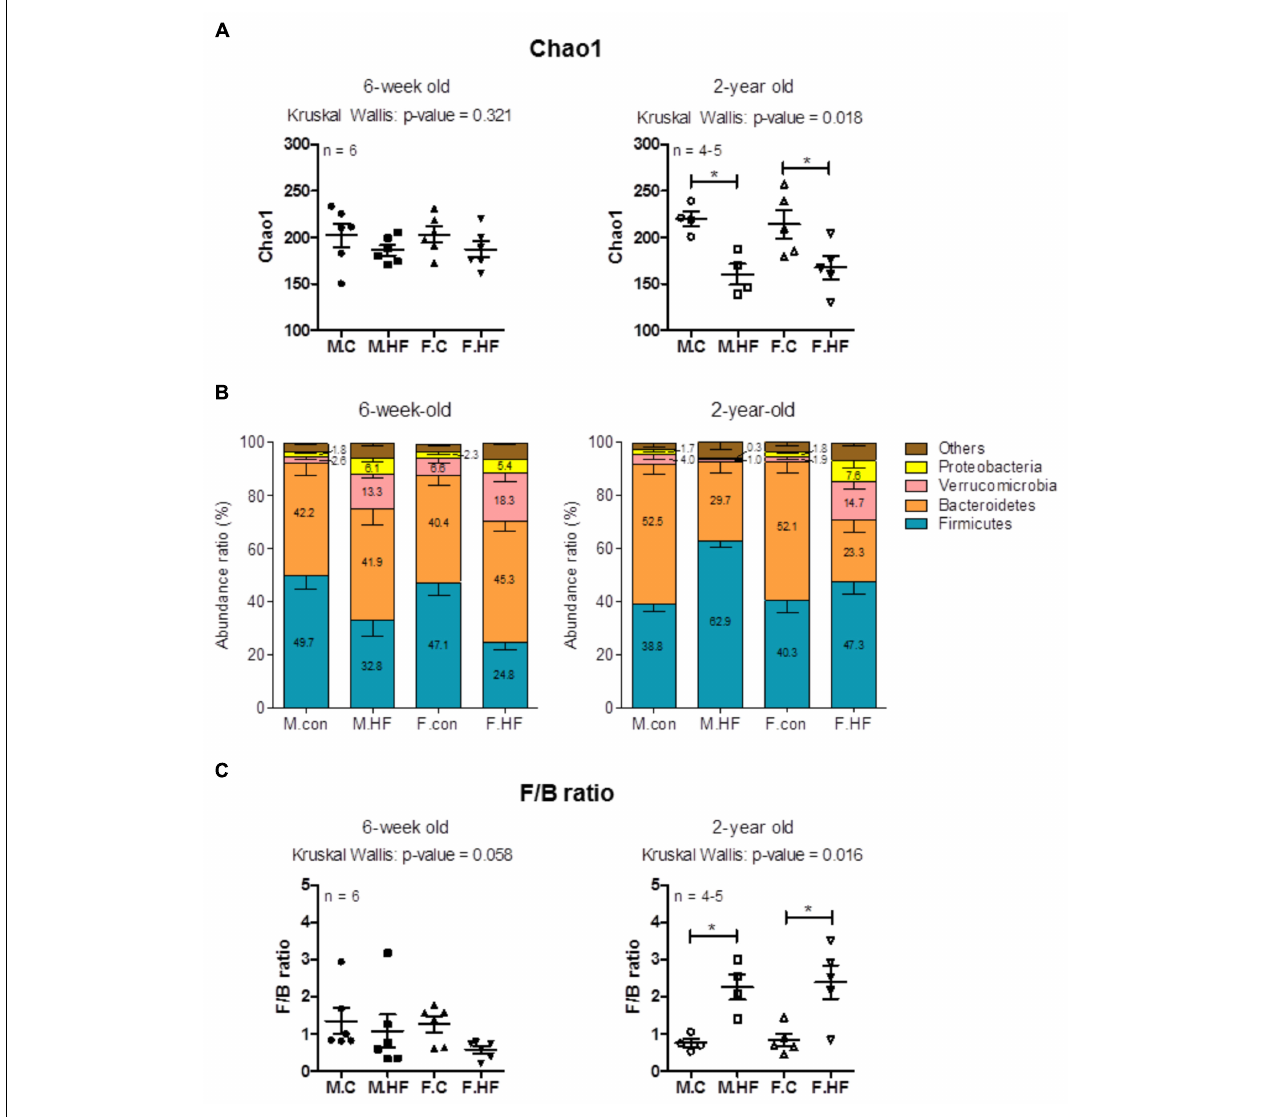
FIGURE 3 | Analysis of species richness and relative abundance ratios of 6-week- and 2-year-old rats. (A) Species richness (Chao1 index) of the microbial community determined using pyrosequencing. (B) Taxonomic composition at the phylum level. The abundance ratio (%) indicates the percentage of each phylum in total microorganisms. Stacked bars of mean and SEM. (C) Firmicutes / Bacteroidetes ratio calculated by dividing the abundance ratio of Firmicutes with that of Bacteroidetes in 6-week- and 2-year-old rats. ( A and C ) Scatter plot (mean, SEM) (6-week-old rats, n = 6; 2-year-old male rats, n = 4; 2-year-old female rats, n = 5). p -Values to Kruskal–Wallis test is designated on the figure; M, male; F, female; C, control; HF, high-fat diet; F/B ratio, Firmicutes / Bacteroidetes ratio.